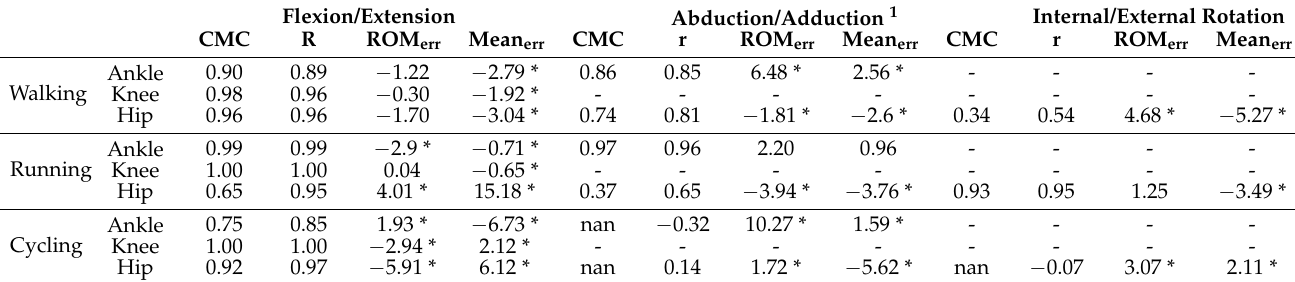
Table 2. Summary of comparisons between Pose2Sim and marker-based angle waveforms. A specific formulation of the coefficient of multiple correlation (CMC) was used, specifically designed to compare different protocols or measurement systems [37]. CMC jointly evaluates correlation, gain, and offset, which were respectively assessed with Pearson’s r coefficient, range of motion errors (ROM err ), and mean errors (Mean err ). * Significant at 5% level. 1 Although ankle subtalar angle combines abduction/adduction and internal/external rotation, it is hereafter reported in the abduction/adduction